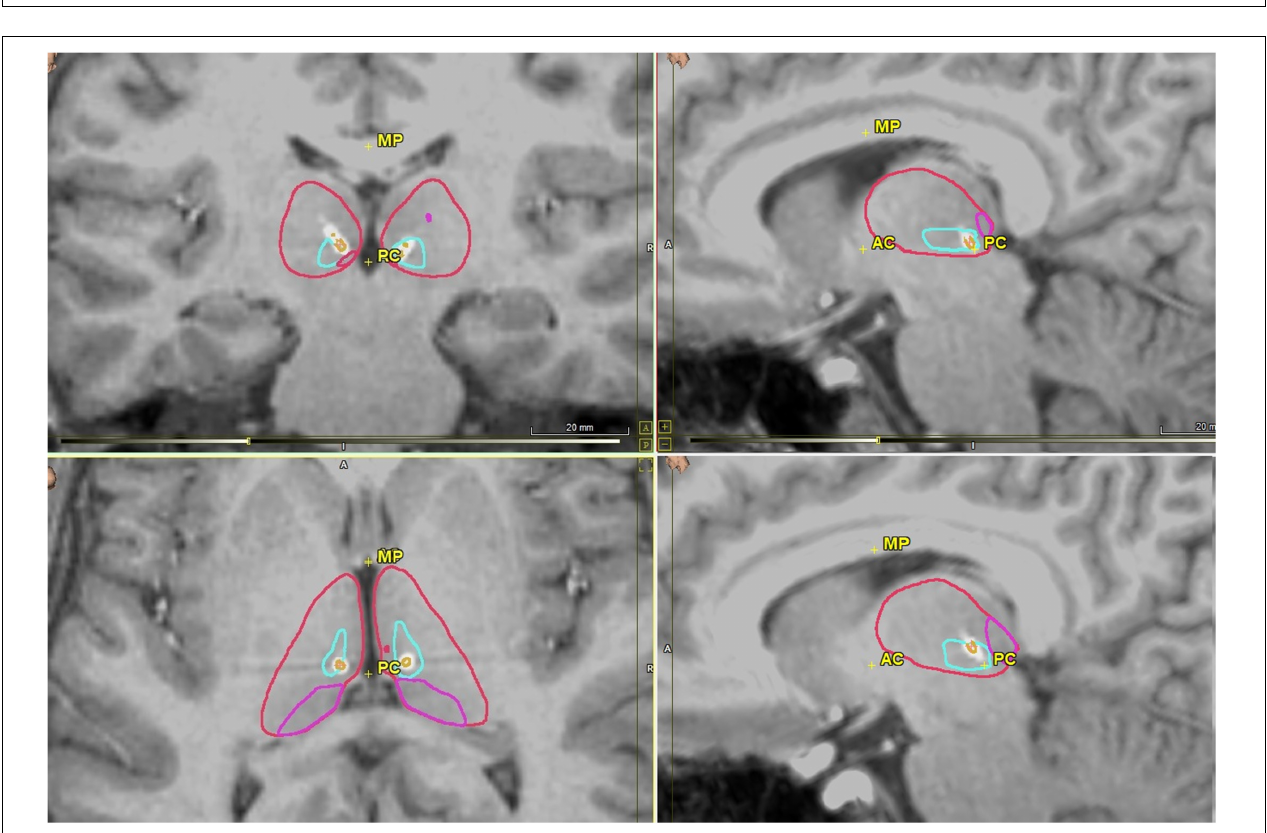
FIGURE 1 | ANT nuclei images with brain atlas overlay of postoperative CT/MRI merge, visualizing implanted RNS depth electrodes. (A) Coronal (upper left and lower left) and sagittal (upper right) views, and 3D-rendered image of implanted ANT nuclei without background brain. (B) Close-up views of implanted leads from rotated sagittal (upper and lower left) and oblique (upper right) views, along with an oblique view 3D-rendered image of implanted ANT nuclei without background brain. ANT nuclei marked in green, mammillothalamic tracts in white, electrodes in brown. Images generated with WayPoint Navigator version 4.6.6.